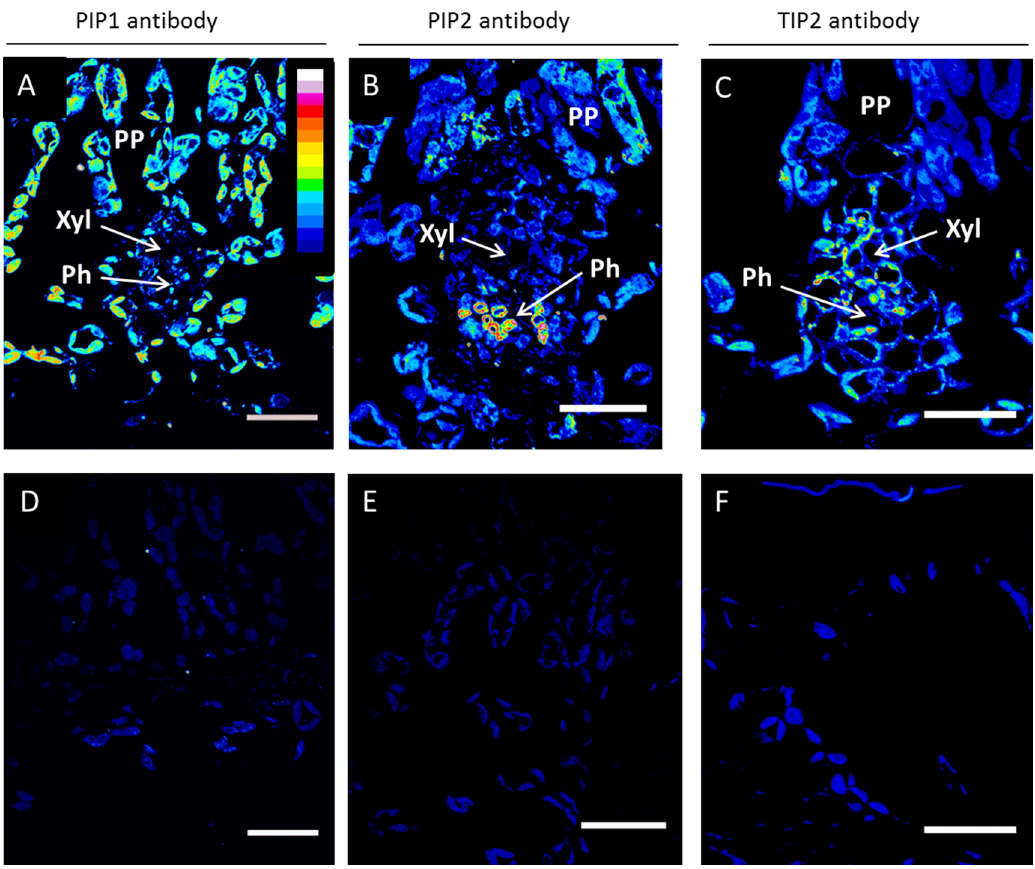
Figure 7. Immunolocalization of AQP proteins in leaves of P.trichocarpa saplings. Confocal laser scanning micrographs showing the localization of PIP1, PIP2, TIP2 proteins in minor veins of leaf transverse sections (A, B, C respectively). Controls with no primary antibody indicate minimal background fluorescence (D, E, F respectively). Images were taken at an identical setting and were color-coded with an intensity look-up- table (LUT; displayed in A), in which black was used to encode background, and blue, green, yellow, red and white to encode increasing signal intensities. Ph, phloem; PP, palisade parenchyma; Xyl, xylem. Scale bars=20 m m.